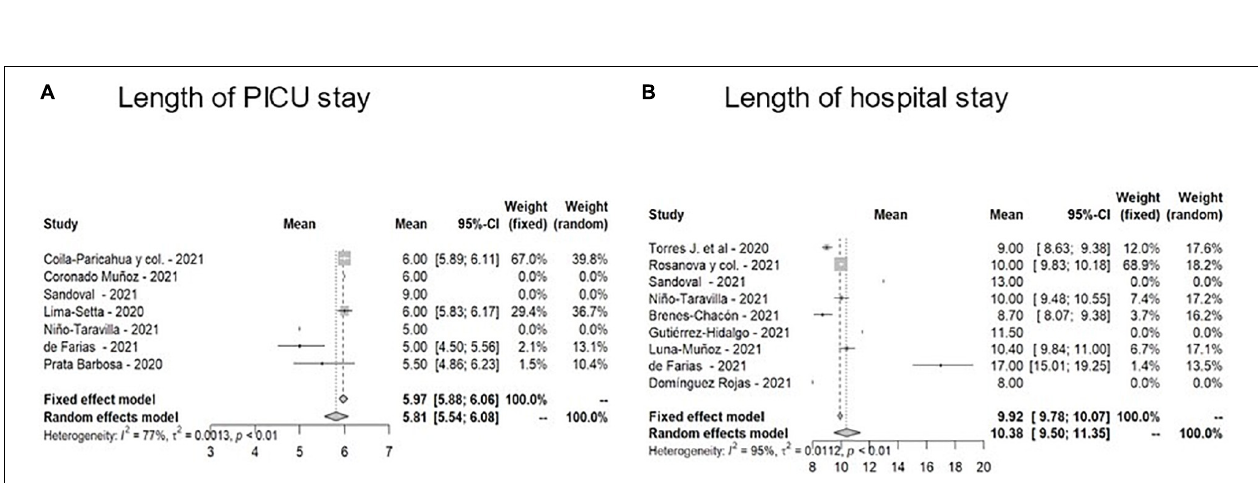
FIGURE 3 | Forest plots of length of stay of patients in the PICU (A) or on the general ward (B) .